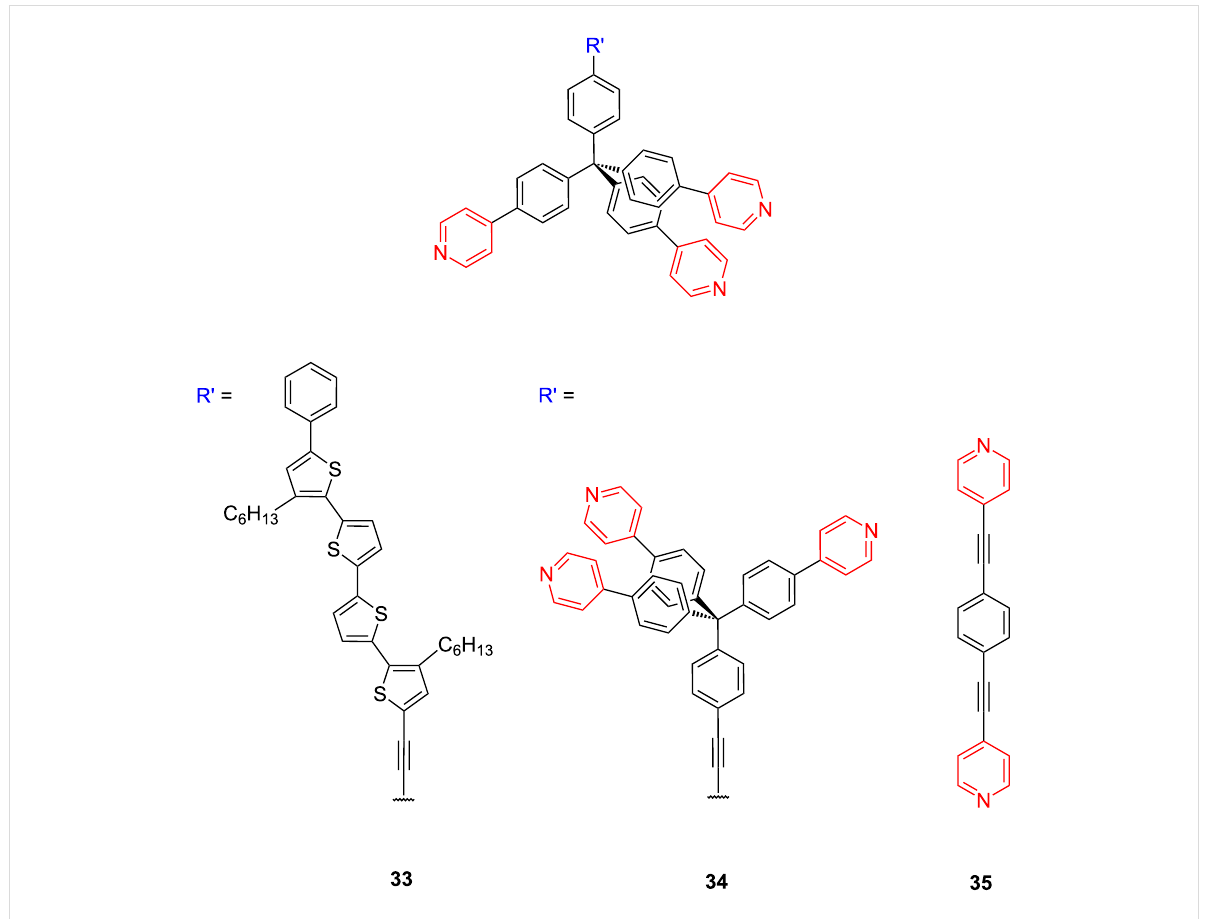
Figure 13: Structure of pyridine terminated platforms 33–35 .